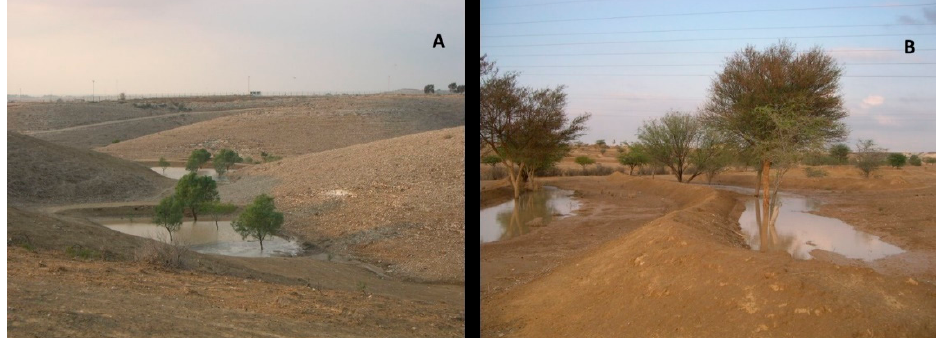
Figure 4. Functional restoration activities in the Negev by controlling the runoff flow. ( A ). Func- tional restoration of the valley by human-made sinks; ( B ). Functional restoration on the slopes by human-made sinks (Source: Itzhak Moshe and Motti Shriki. Loess watershed Northern Negev, winter season).